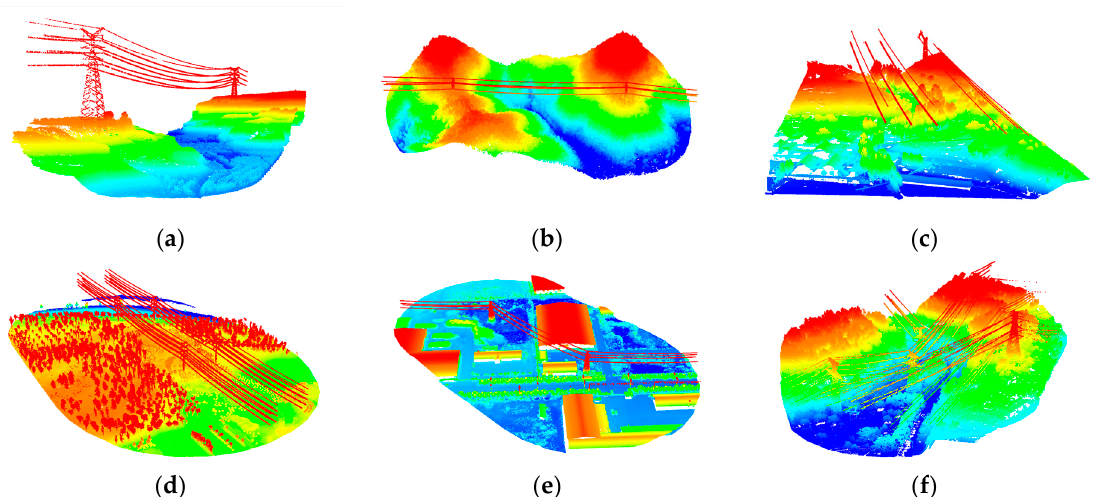
Figure 4. Training data of different terrains: ( a ) valley; ( b ) dense vegetation; ( c ) terraced field; ( d ) plain with sparse forest; ( e ) plain with the building area; and ( f ) steep forests with abundant vegetation.